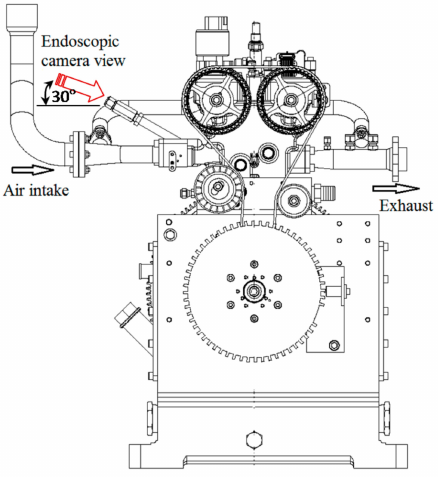
Figure 1. The imaging devices.